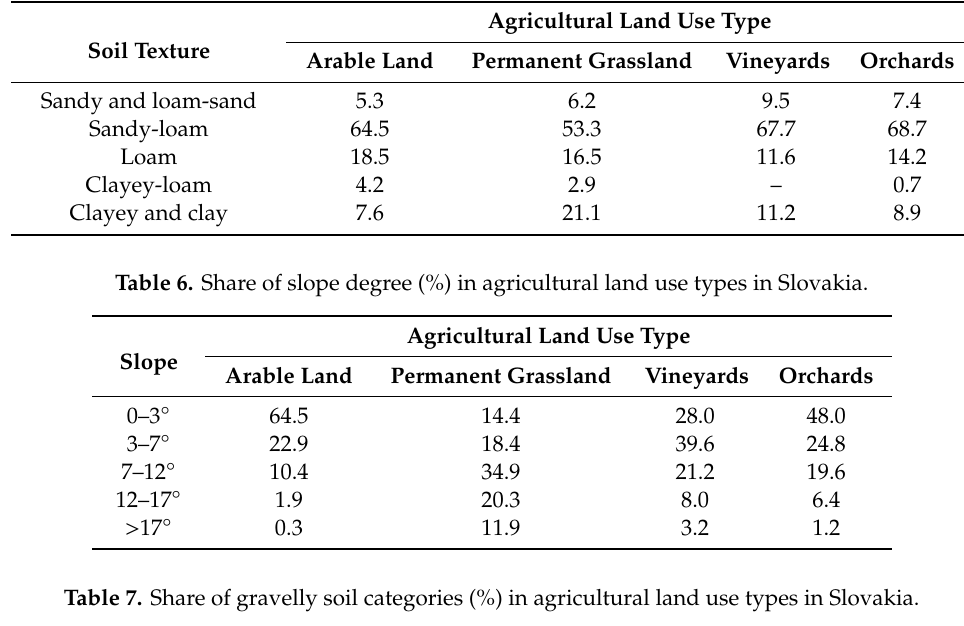
Table 7. Share of gravelly soil categories (%) in agricultural land use types in Slovakia. Gravelly Soil Categories